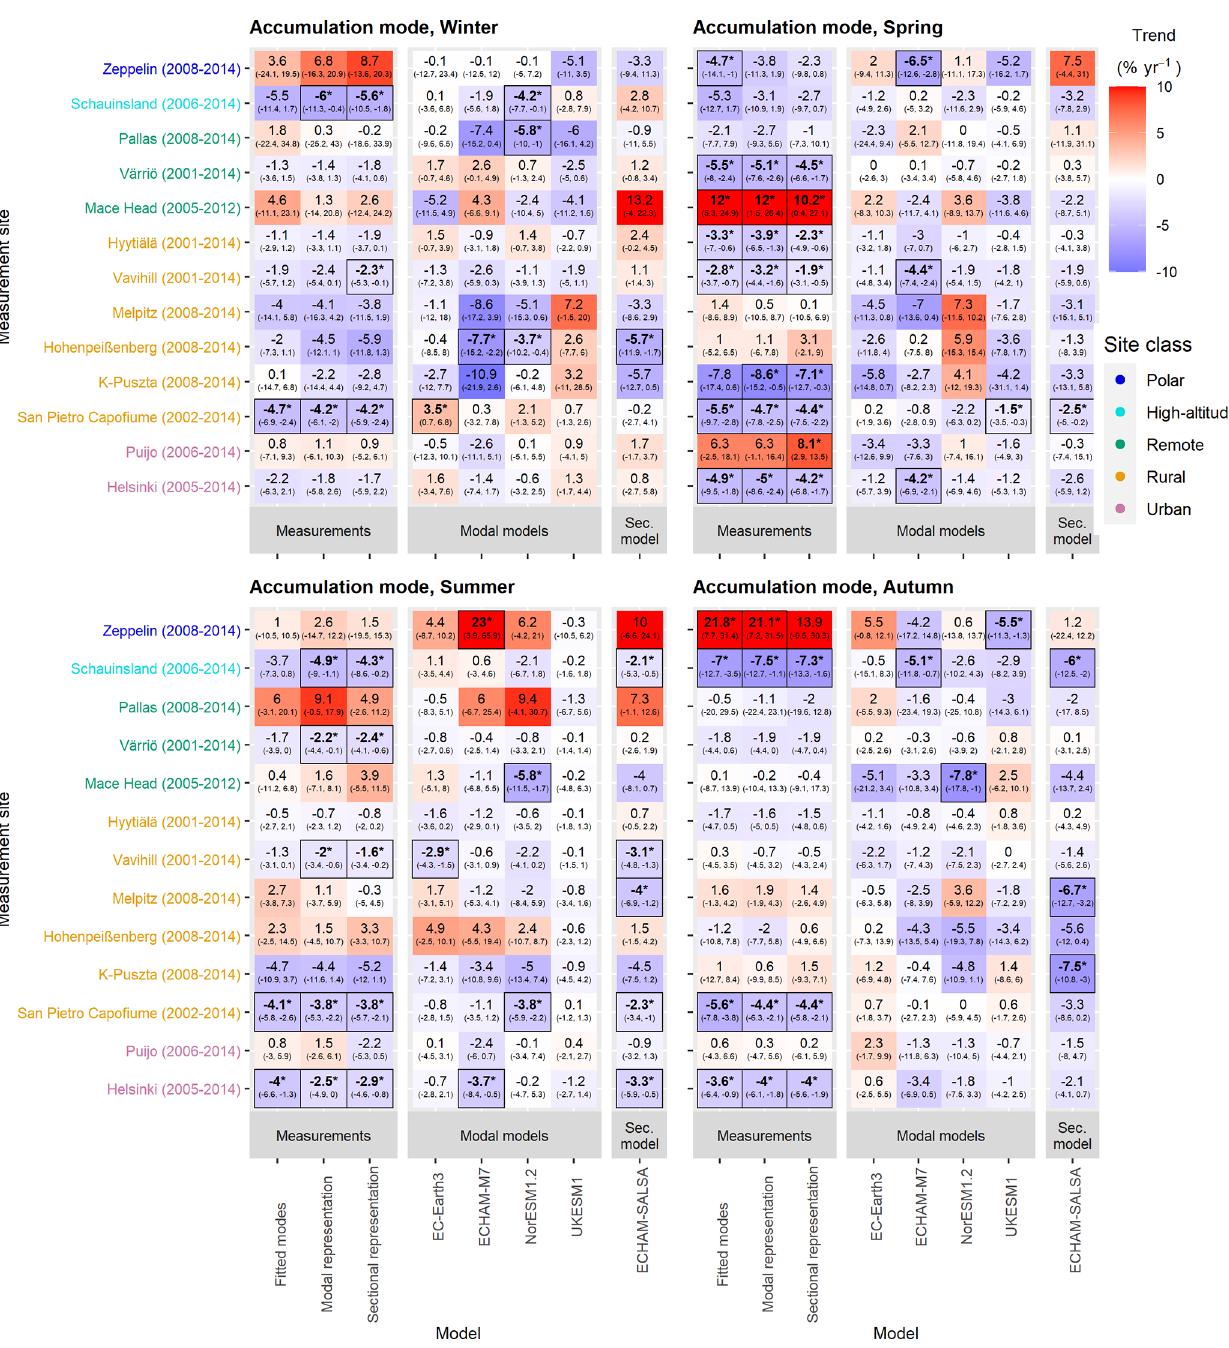
Figure 10. Seasonal trend estimates for accumulation mode number concentration for four seasons: winter (January, February, December), spring (March, April, May), summer (June, July, August), and autumn (September, October, November). Sites are ordered by site class and within site class from most northerly to most southerly. Bold numbers, asterisks, and line borders around the estimate indicate that the trend is statistically significant (95% confidence level). Trends have been calculated using the Sen–Theil estimator and complemented with bootstrap confidence intervals (see Sect.